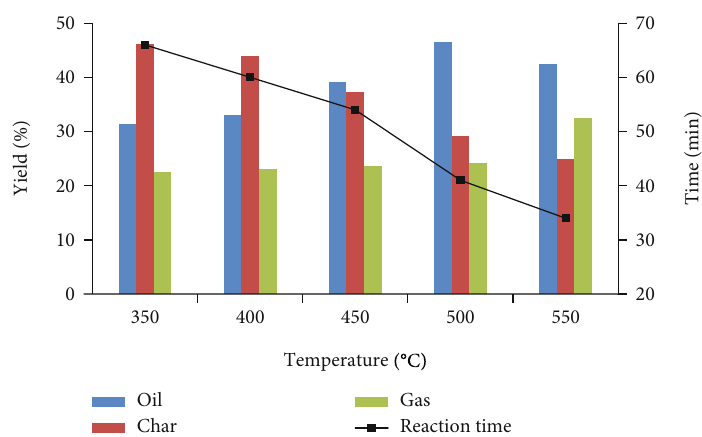
Figure 3: E ff ect of temperature on yields of NOC thermal pyrolysis.